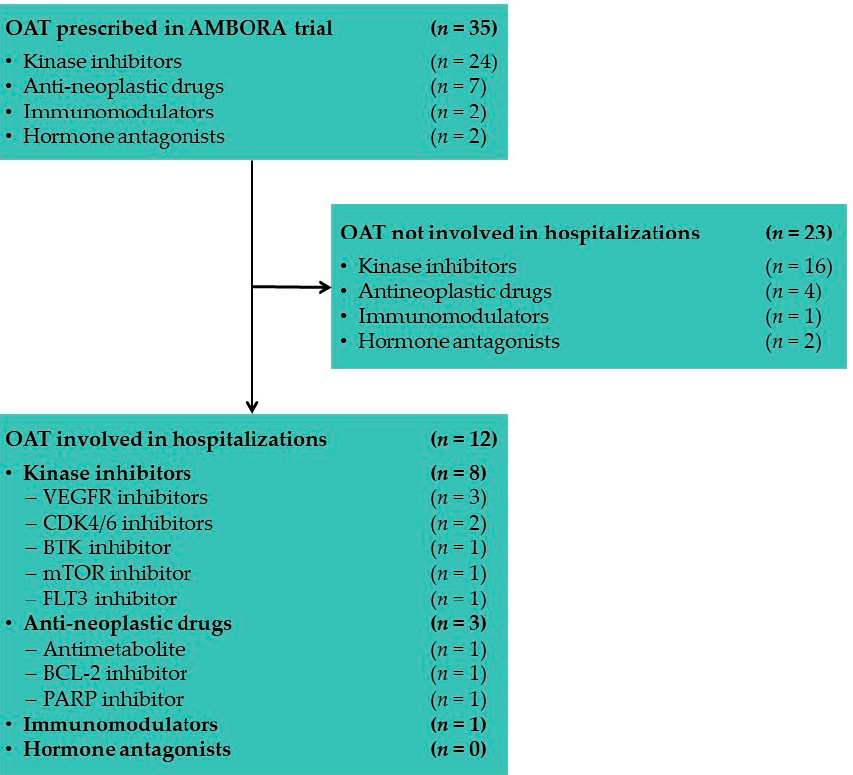
Figure 3. Overview of OAT prescribed and involved in OAT-related hospitalizations including their underlying mechanism of action and target structures within AMBORA. Abbreviations: BCL-2, B-cell lymphoma protein 2; BTK, Bruton’s tyrosine kinase; CDK4/6, cyclin-dependent protein kinases 4/6; FLT3, FMS-like tyrosine kinase; mTOR, mitogen-activated protein kinase; OAT, oral anticancer treatment; PARP, Poly(ADP-ribose) polymerase; VEGFR, vascular endothelial growth factor receptor.